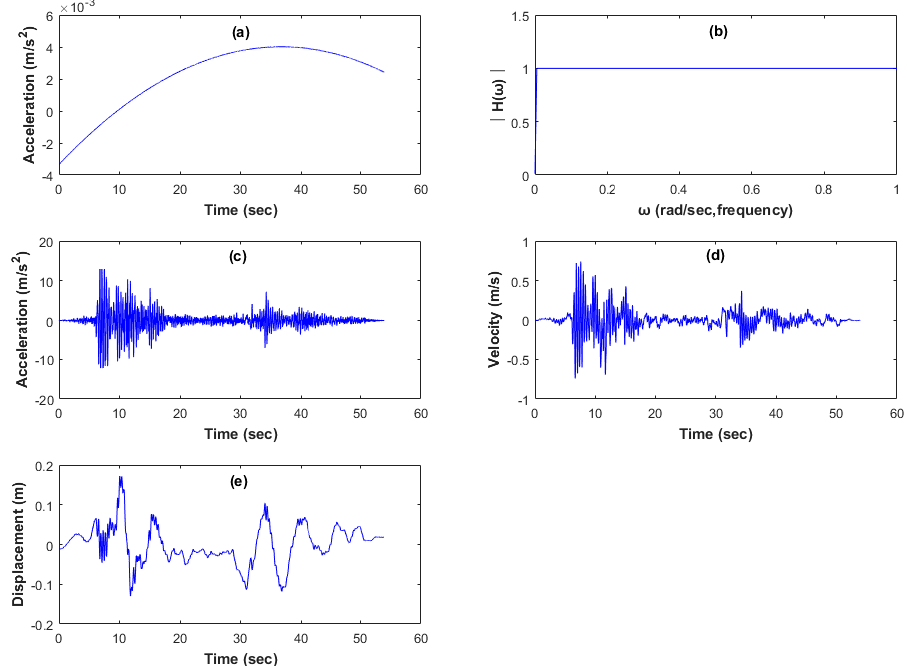
Figure 18. Analysis process for the 10th-story acceleration during the Manjil earthquake using Method 3: ( a ) 2nd-order polynomial equation for correcting acceleration; ( b ) 4th-order Butterworth high-pass filter; ( c ) acceleration; ( d ) velocity; ( e ) displacement.